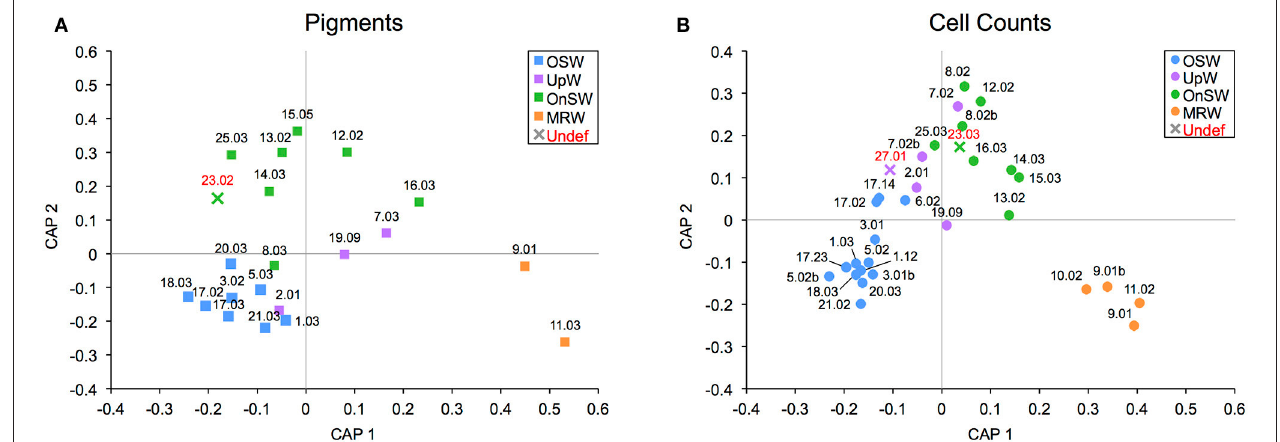
FIGURE 8 | Addition of samples with undefined habitat types into canonical analysis of principal coordinates (CAP) ordination plots for diagnostic pigment (A) and species-specific cell count (B) community data. Samples that were added are labeled in red, and their marker color matches that of the closest